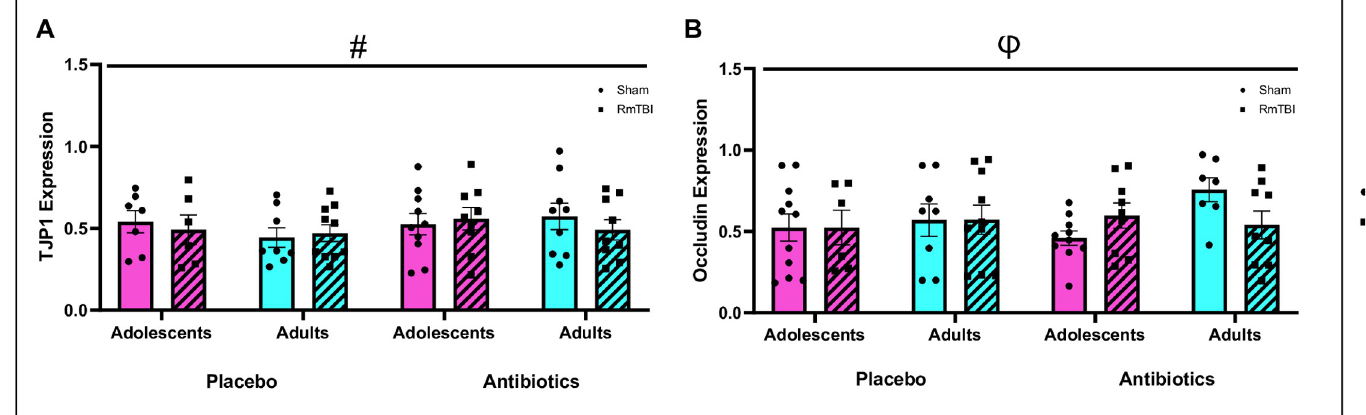
Fig 9. Gene expression of intestinal tight junction proteins TJP1 and Occludin. Means and individual data points ± standard error are shown. (#) indicates a main effect of treatment, ( φ ) indicates a significant interaction; p ’s < .05. A) Displays TJP1 concentration, whereby antibiotics groups had increased expression of TJP1, B) Displays occludin concentration, whereby interactions observed were Injury � Age whereby expression was increased in placebo+RmTBI and antibiotic+RmTBI adolescent rats and reduced in placebo+RmTBI and antibiotic+RmTBI adult rats.